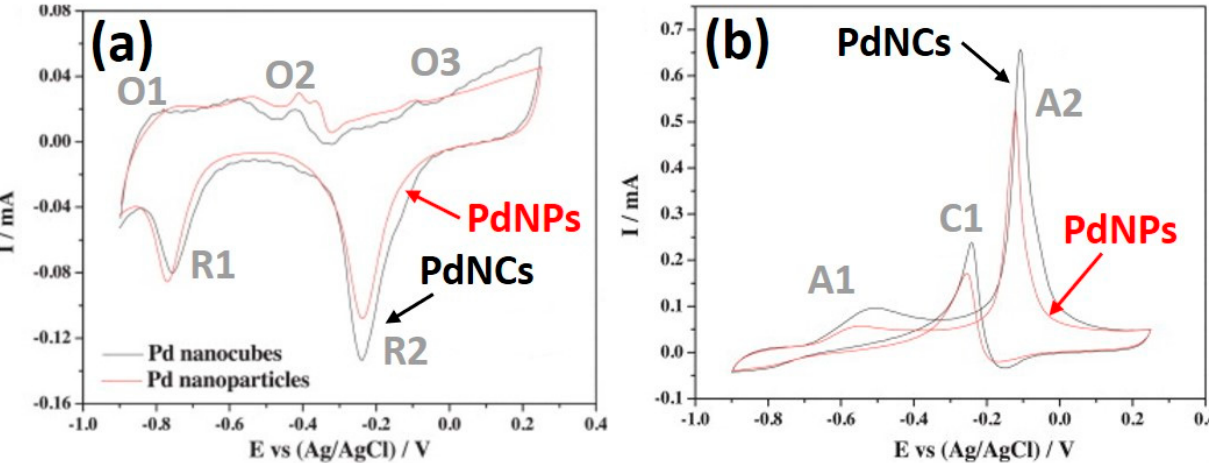
Figure 8. CV curves of the PdNCs and the PdNPs in a N 2 -saturated 0.1 M NaOH electrolyte, which was ( a ) without the introduction of 5 mM glucose and ( b ) with the introduction of 5 mM glucose. (Black curves: PdNCs; Red curves: PdNPs; “O” and “A” symbols: reactions occurred in the positive scan (forward scan); “R” and “C” symbols: reactions took place in the negative scan (backward scan)). (Reproduced with permission from [34]. Copyright Elsevier, 2015). Figure 8b shows the results of the current responses of the PdNCs (black curve) and the PdNPs (red curve) electrodes under a certain potential range in 5 mM glucose in 0.1